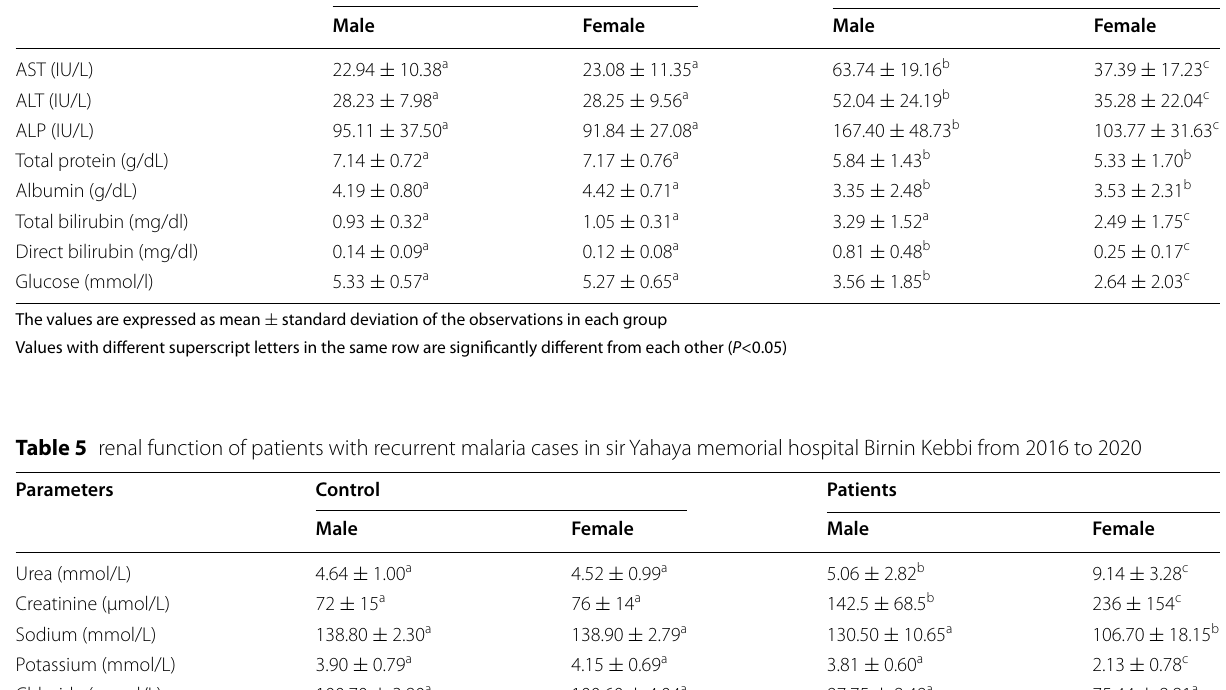
The values are expressed as mean standard deviation of the observations in each group ± Values with different superscript letters in the same row are significantly different from each other ( P <0.05)